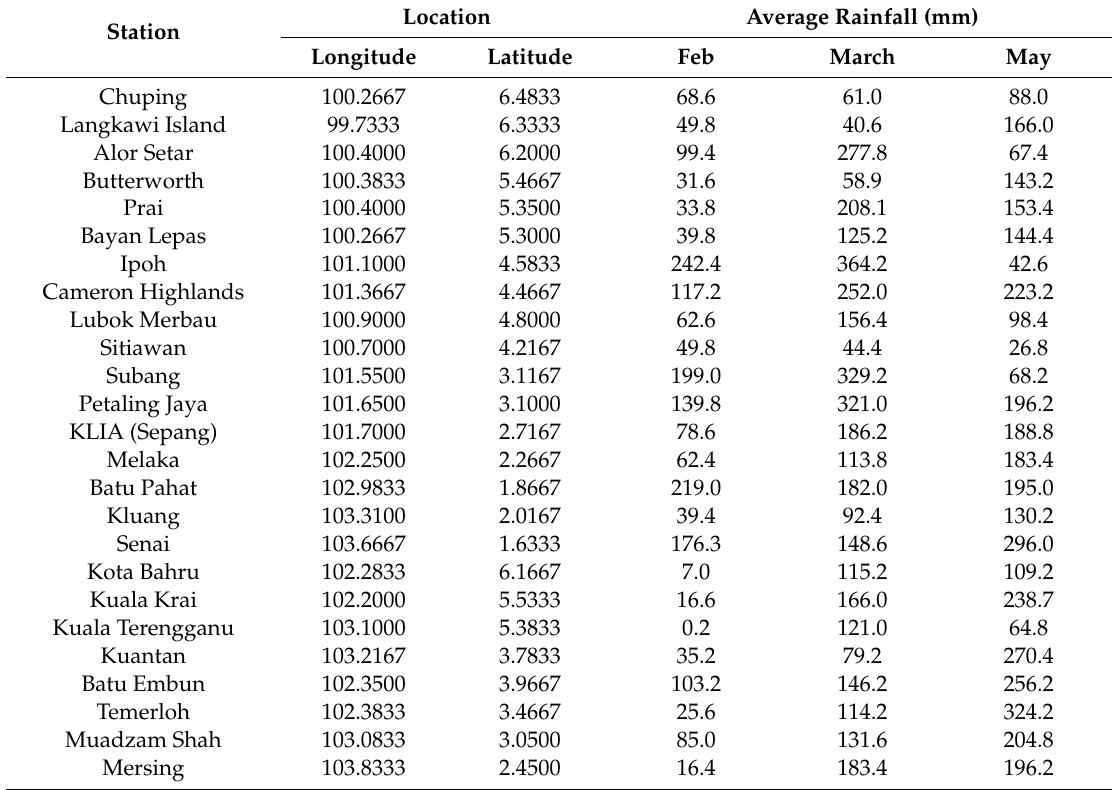
Table 10. Rainfall